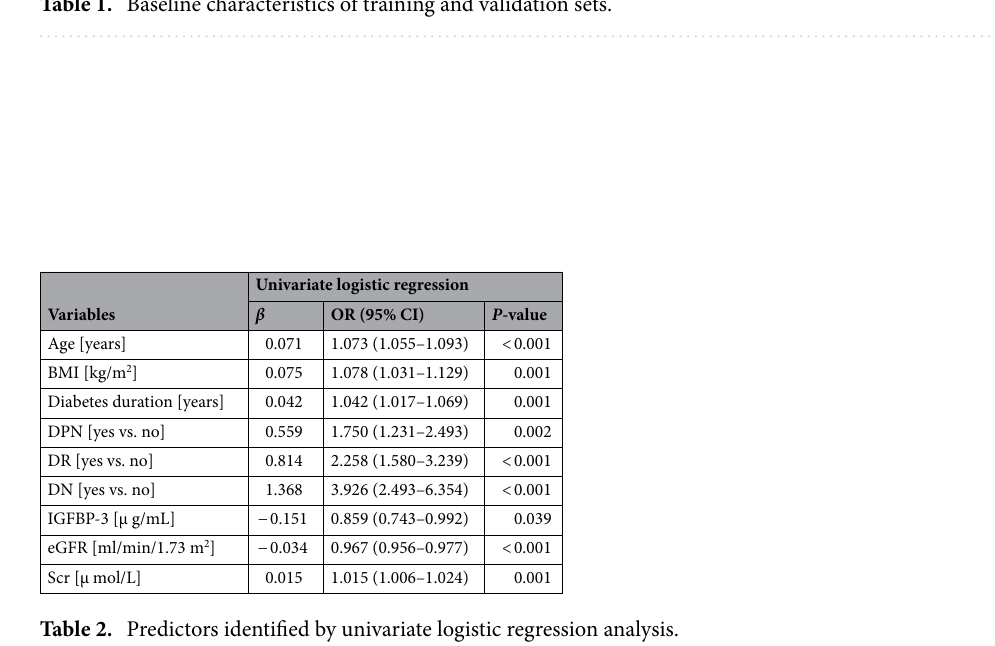
Table 1. Baseline characteristics of training and validation sets.